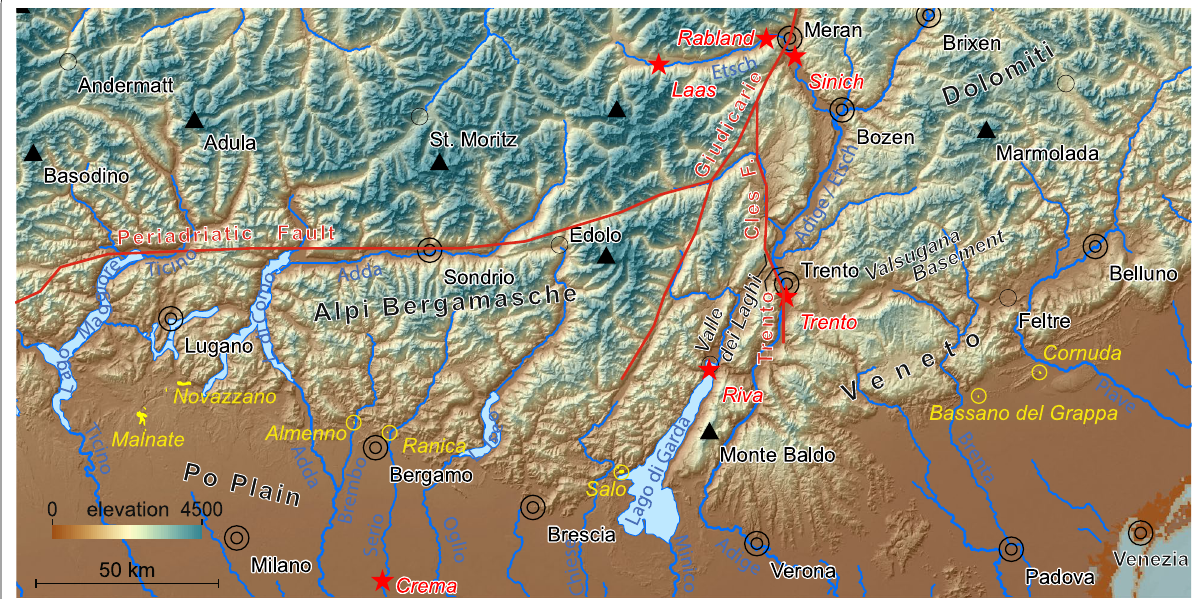
Fig. 1 Overview of the topography in the study area. Marine Pliocene sediments are marked in yellow. The cross sections of Fig. 2 are marked as red